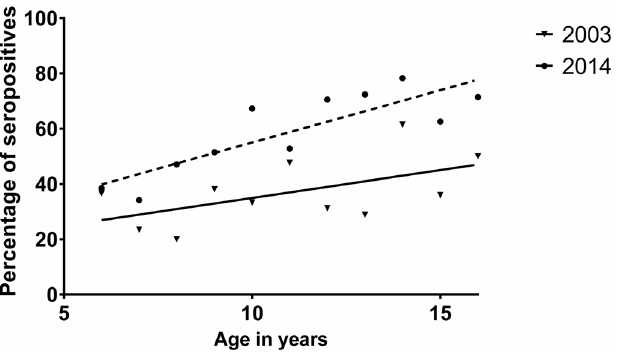
Fig 2. Comparison of the age stratified seroprevalence rates in children over a period of 12 years. The age stratified seroprevalence rates were compared in children aged 6 to 16 years in 2003 and